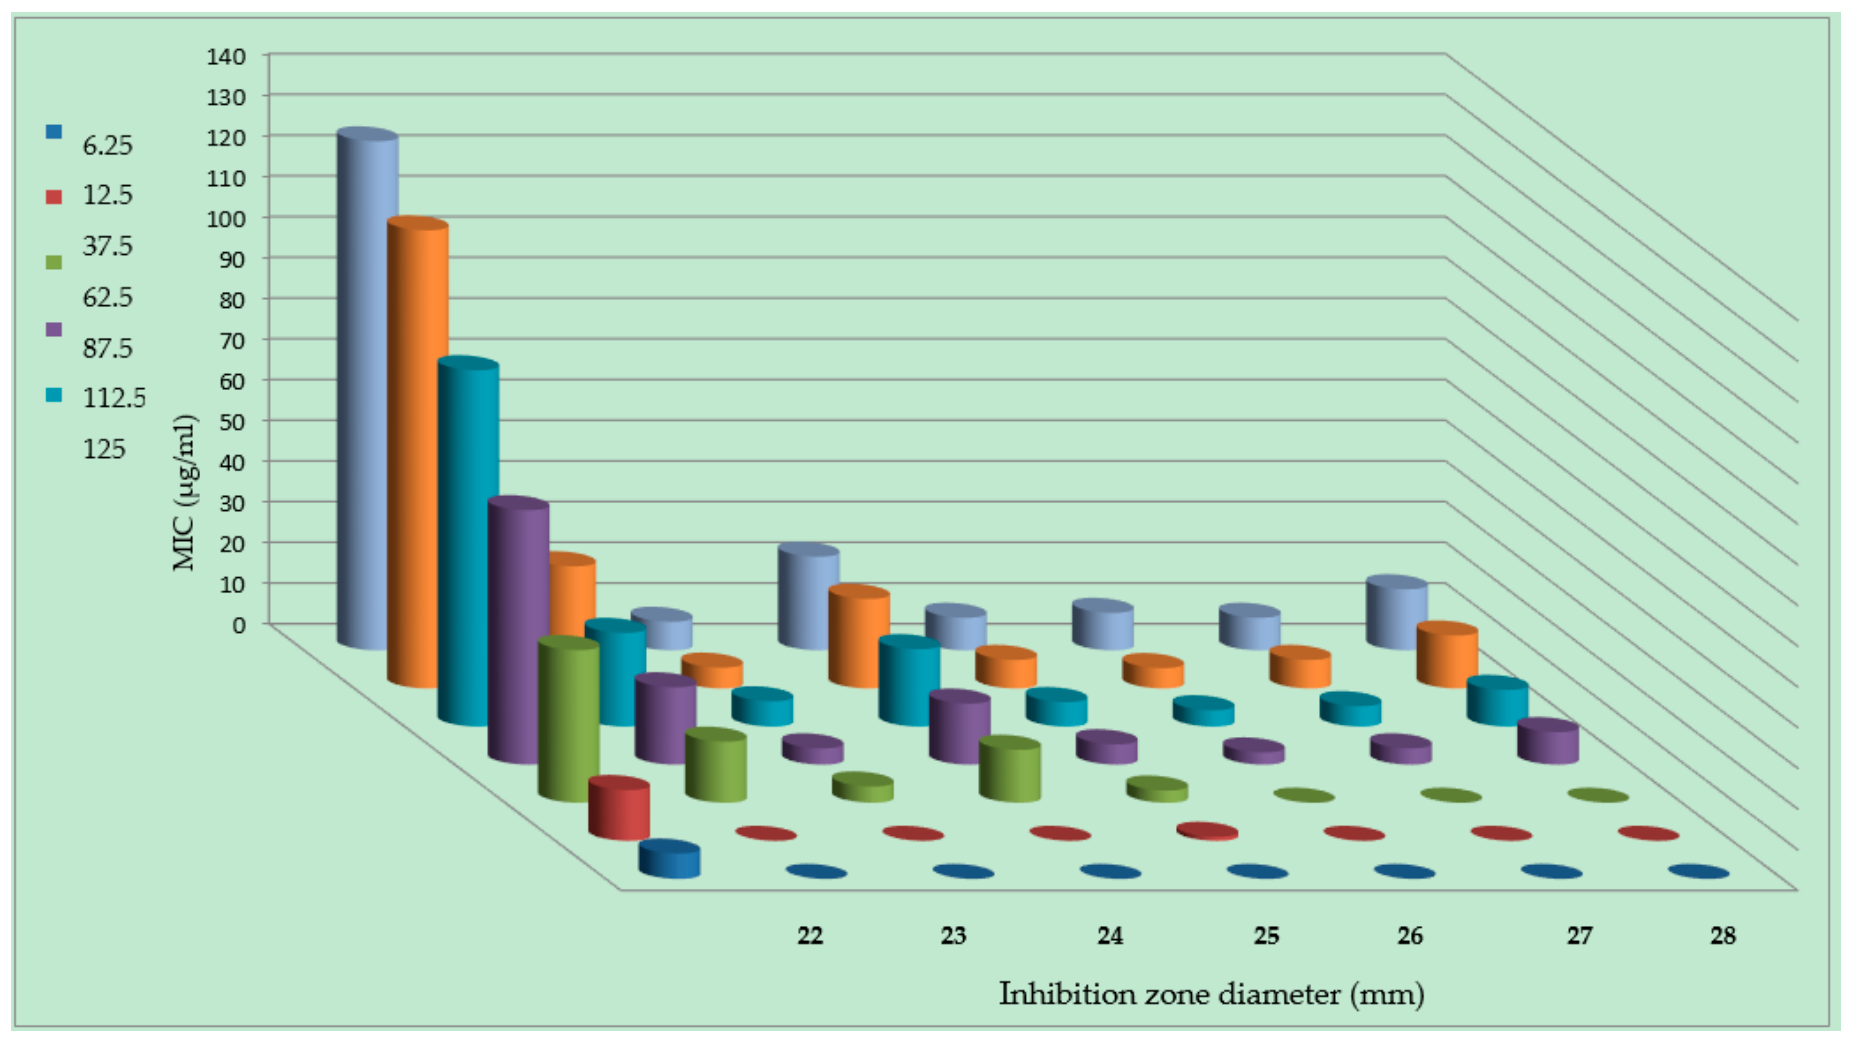
Figure 5. Antibacterial susceptibility of species S. pyogenes given as MICs values in µg/mL for compounds 22 – 28.